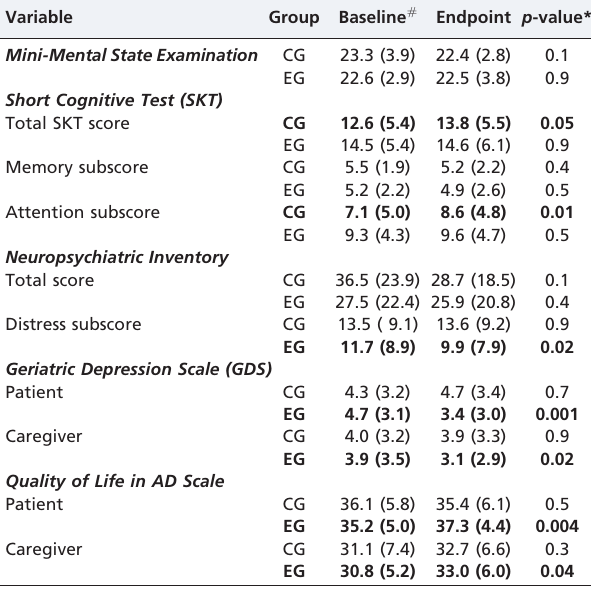
EG, experimental group; CG, control group. Values represent means and standard deviations (SD) of test scores; * p -values in the right column: paired-sample t tests addressing within- group differences (baseline vs . endpoint) in test scores (significant differences are shown in bold). # Independent-sample t tests comparing mean scores at baseline yielded nonsignificant differences between EG and